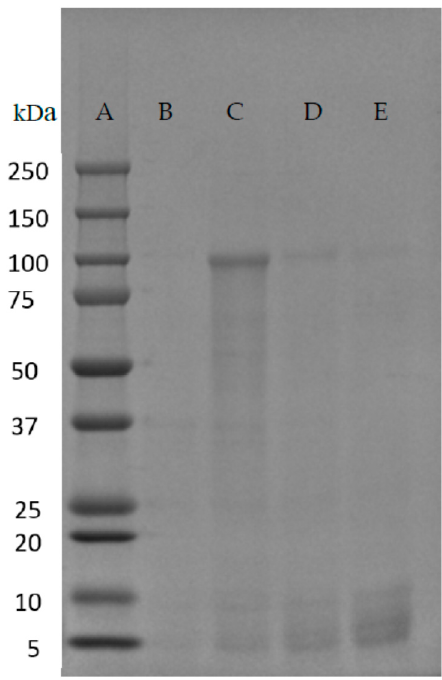
Figure 3. SDS-PAGE of Parr vessel temperature/pressure solubilization of rMaSp2 (predicted 98.7 kDa). ( A ) Bio-Rad Dual Color prestained protein molecular weight (MW) marker (MW listed to the left); ( B ) Soluble rMaSp2 at 120 °C and 127 psi; ( C ) Soluble rMaSp2 at 130 °C and 131 psi; ( D ) Soluble rMaSp2 at 140 °C and 155 psi; ( E ) Soluble rMaSp2 at 150 °C and 161 psi.